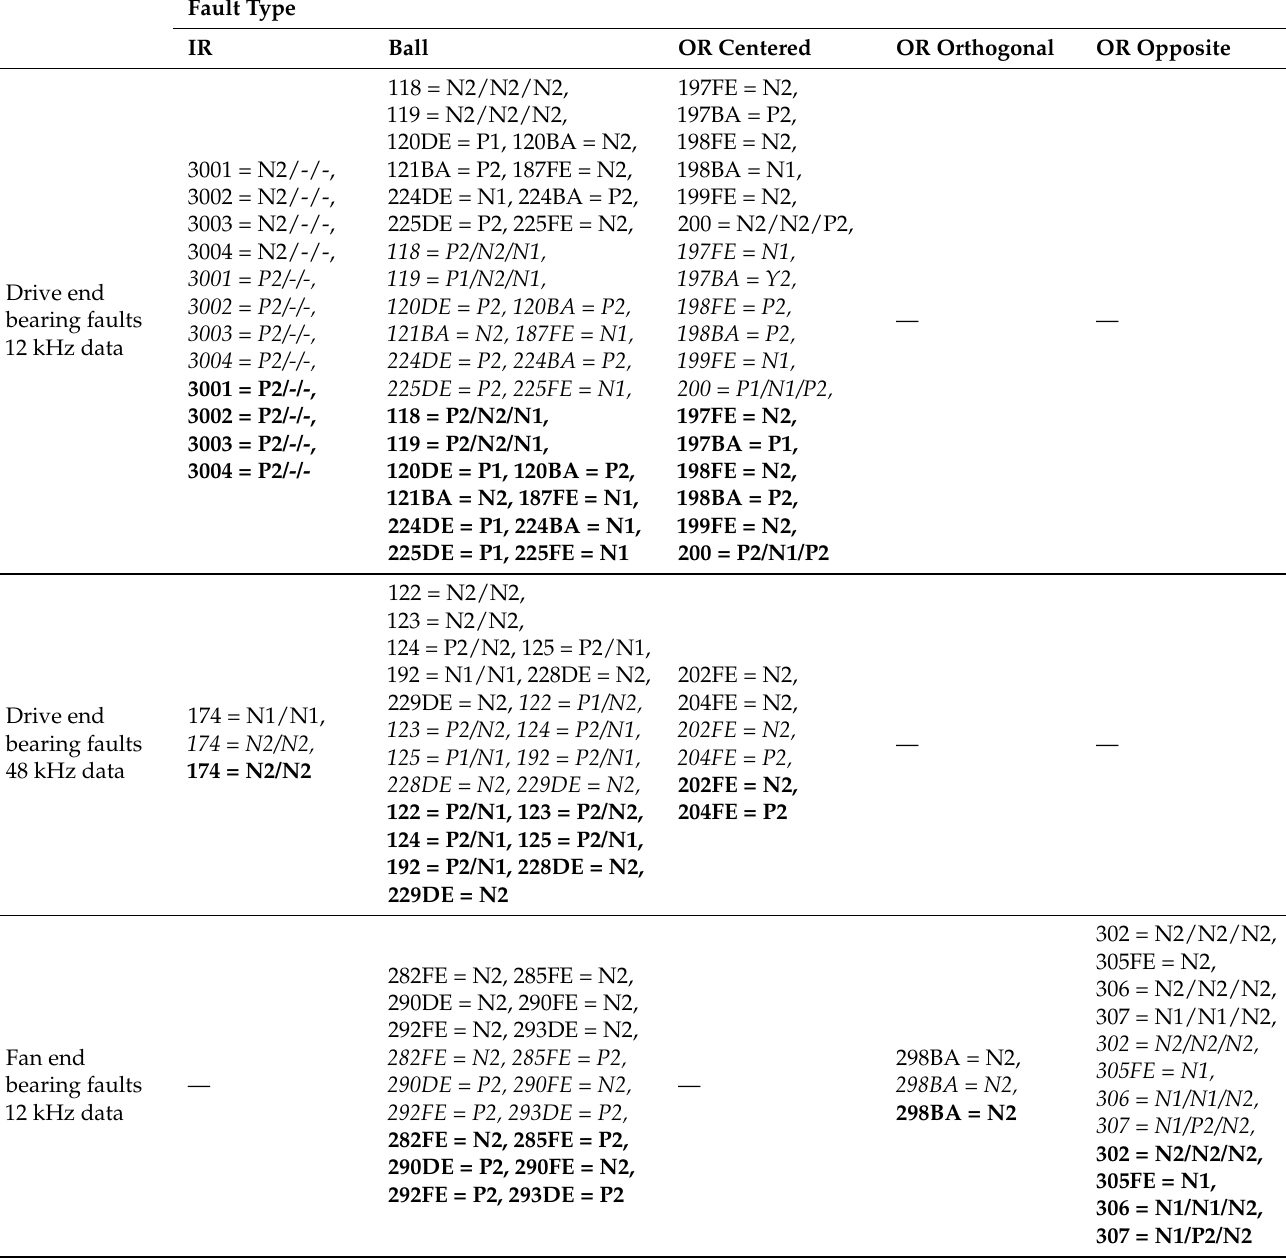
Table 6. Categorization of nondiagnosable records in [32] using SSK (normal font), SE (italic), SSE (bold). Each sampled record has three simultaneous measurements DE/FE/BA. Diagnosable records per approach: 7 partially diagnosable (SSK), 1 diagnosable and 26 partially diagnosable (SE), 25 Partially diagnosable records (SSE). Fault Type OR Centered OR Orthogonal OR